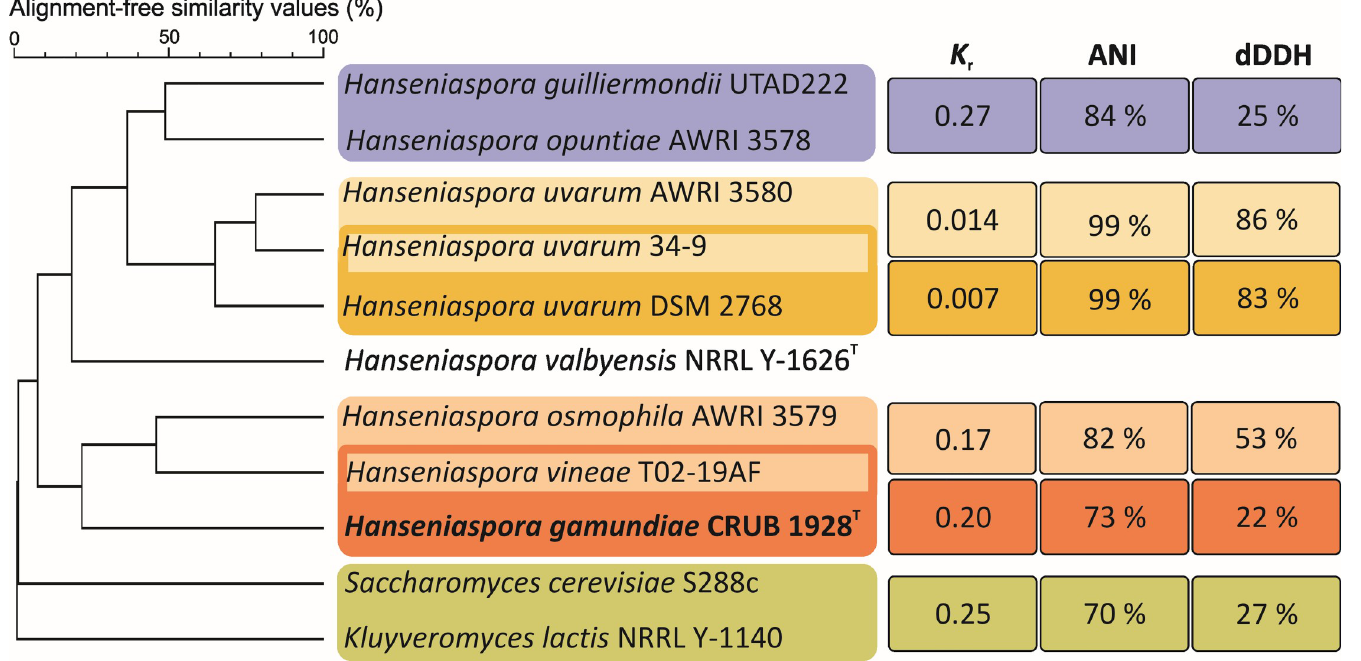
Fig 2. Phylogenomic relationships of the nine Hanseniaspora strains based on an alignment-free matching algorithm with a nine bases DNA seed. Saccharomyces cerevisiae and Kluyveromyces lactis were used as outgroups. Similarities among closely related genomes are presented as the Alignment-Free Distance Measure ( K r ), Average Nucleotide Identity (ANI) and by estimating digital DNA-DNA Homology values (dDDH